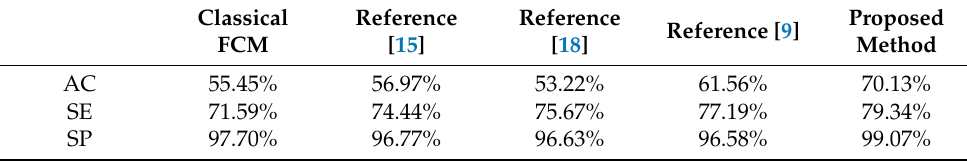
Table 7. The performance of different pupil segmentation algorithms on Dataset